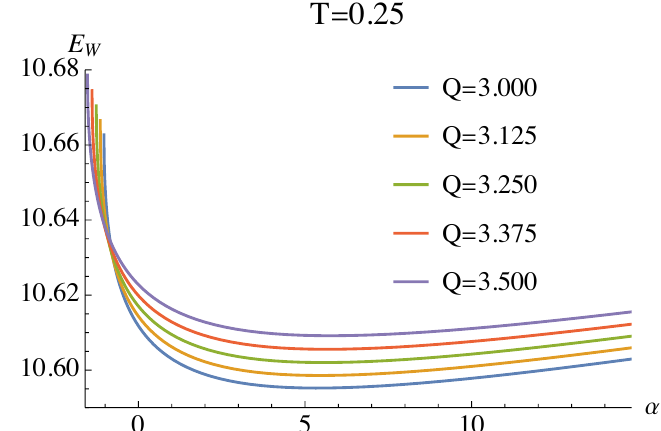
Figure 13 . The EWCS vs α in different value of Q and the configuration ( a, b, c ) is (0 . 6 , 0 . 1 , 0 . 3) .The EWCS shows the non-monotonicity with the increase of α at every Q . We can see that the EWCS first decreases with Q and α , and then turns into an